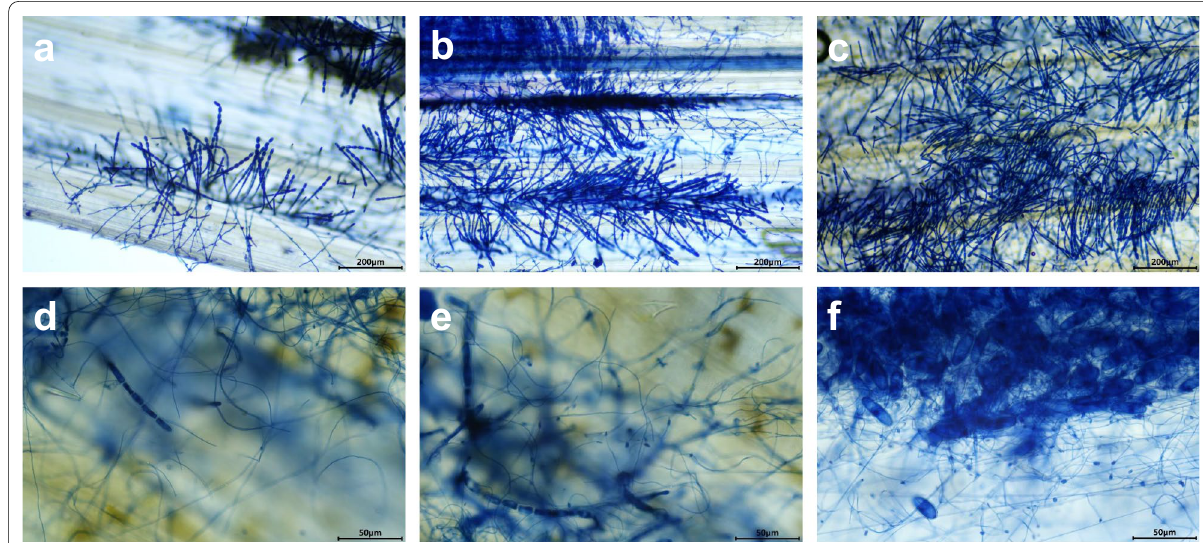
Fig. 3 Colonies of Blumeria graminis f. sp. tritici ( Bgt ). a – c Bgt colonies treated with water at 3, 6 and 9 dpi. d – f Bgt colonies treated with S. aogashimaense spore suspension at 3, 6 and 9 dpi, respectively. Scale bar